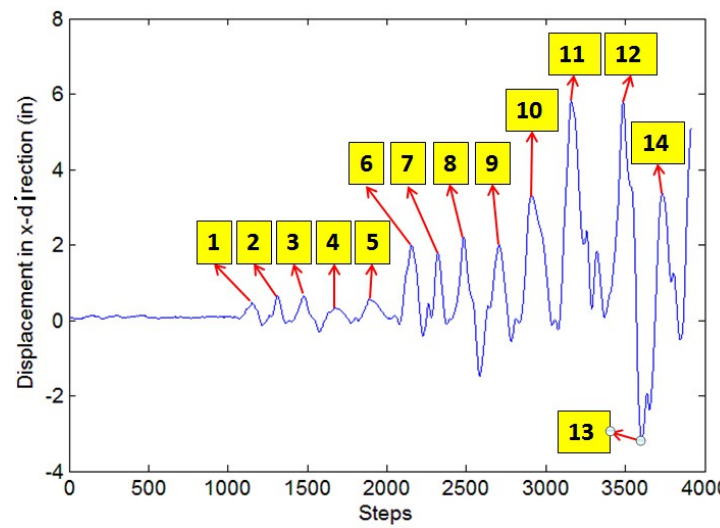
Figure 9. Displacement history in x ‐ direction of the column.